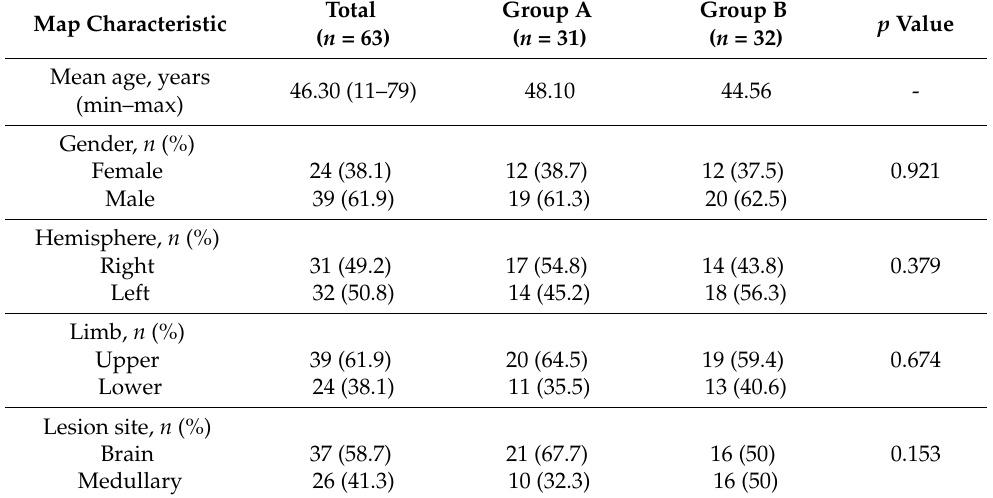
Table 2. Distribution of maps in the two groups according to patient characteristics, brain area and lesion